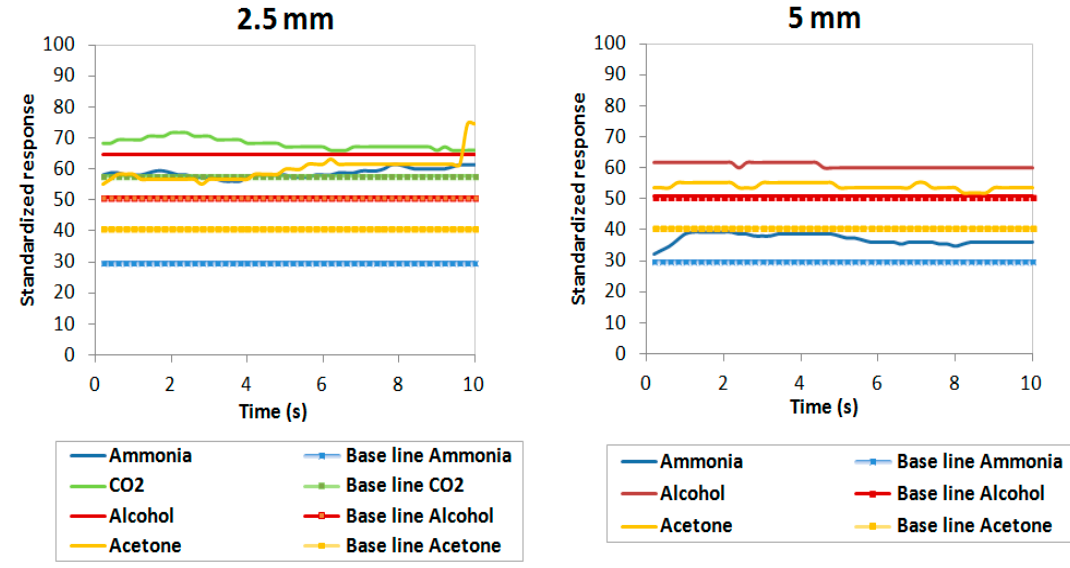
Figure 7. Responses of the four sensors in P. aeruginosa PAO1 in solid cultures with 10 8 CFU/cm 2 .